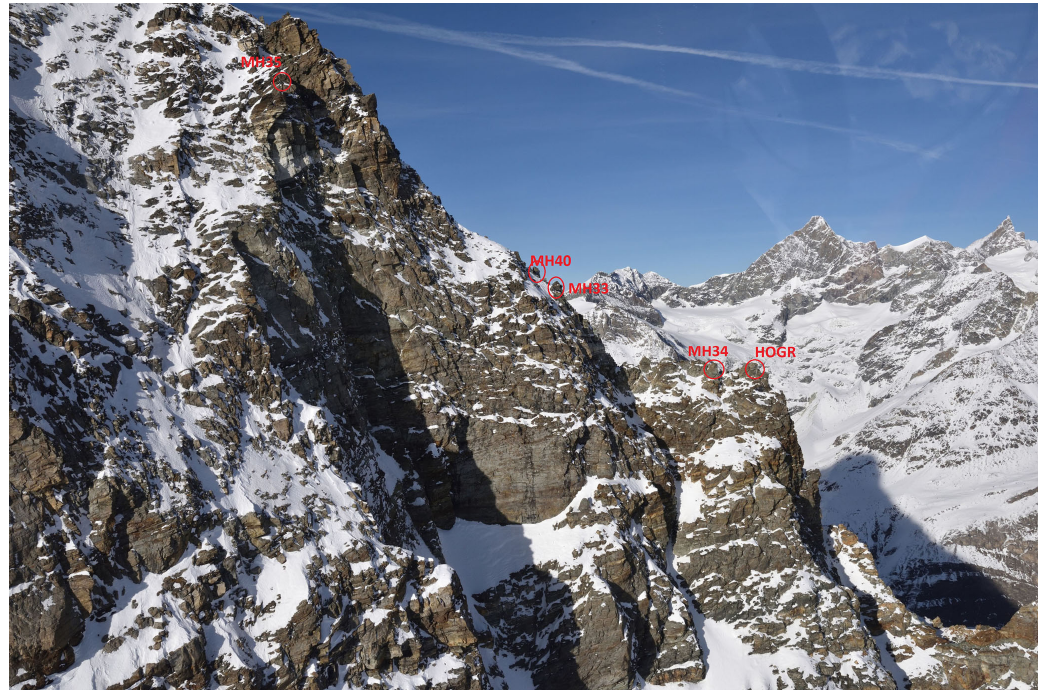
Figure C11. Winter view of the whole field site when approaching from the south. The red circles denote the GNSS measurement positions. The detachment zone is located in the shadow between positions MH33 and MH34.